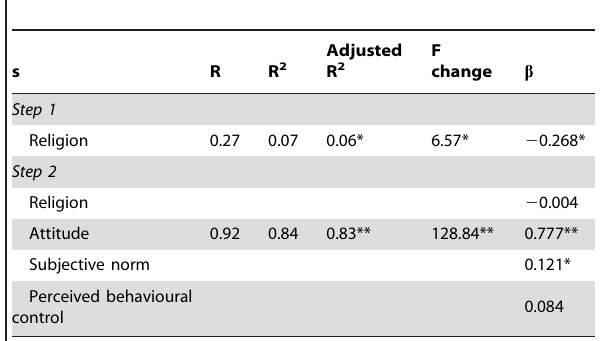
Table 2. Hierarchical multiple regression of intention to register consent on religion (Step 1) and the theory of planned behaviour direct constructs (Step